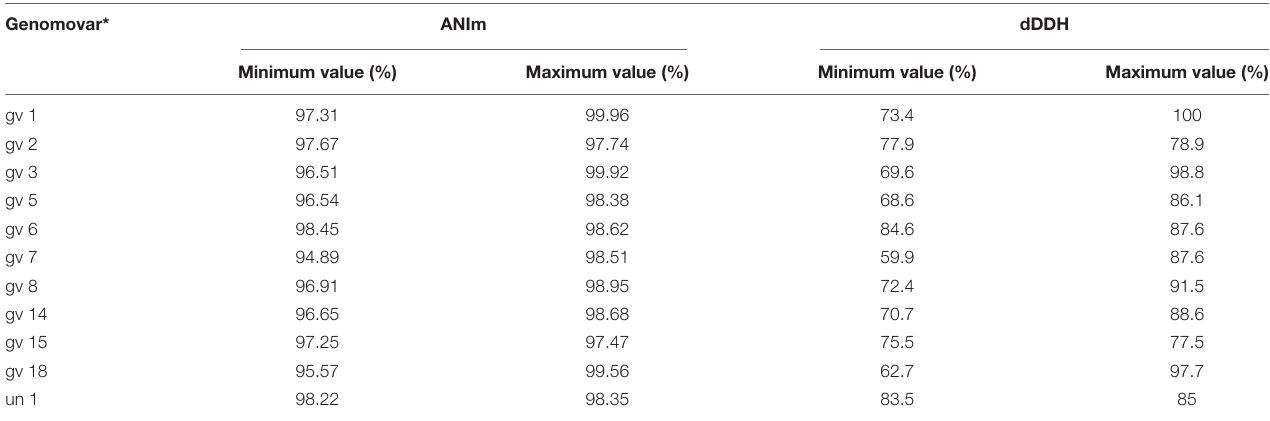
TABLE 1 | The range of ANI and dDDH values within each genomovar.